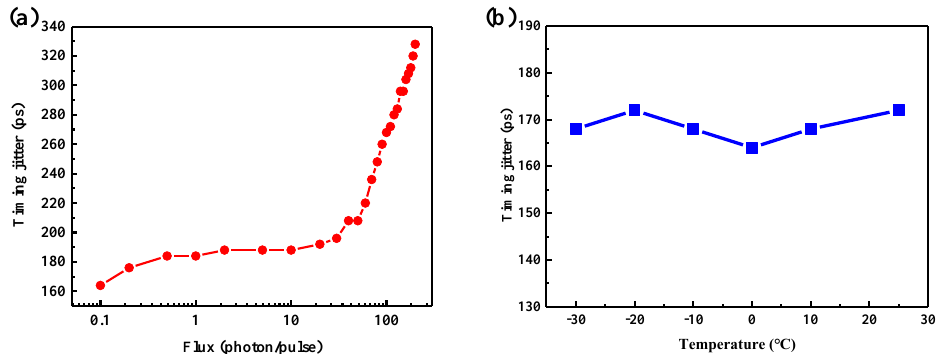
Figure 7. ( a ) Timing jitter as a function of incident photon flux. ( b ) Timing jitter vs. APD’s operation temperature.